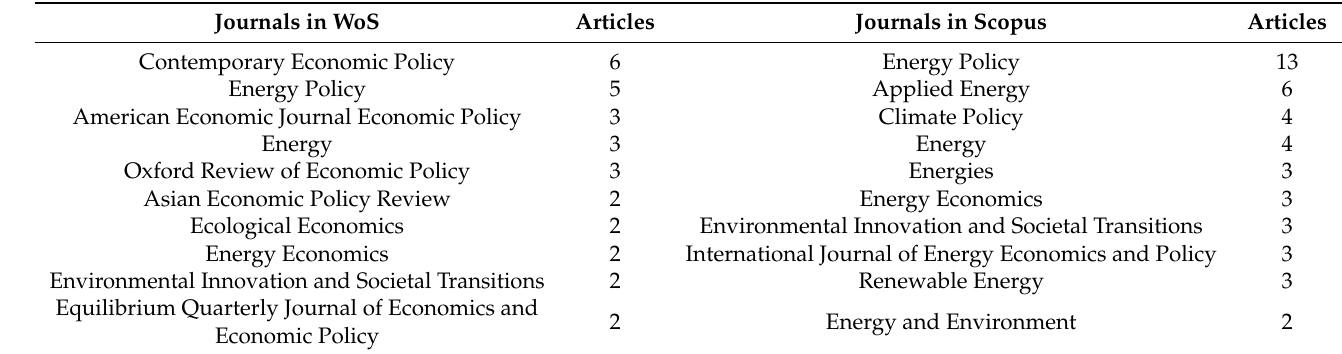
Table 3. Top 10 Journals in Web of Science and Scopus for second